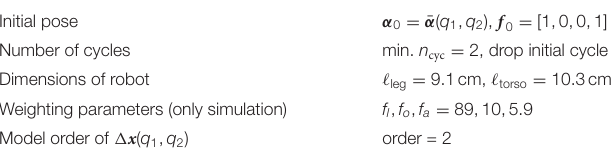
TABLE 2 | Influencing factors on simulation and